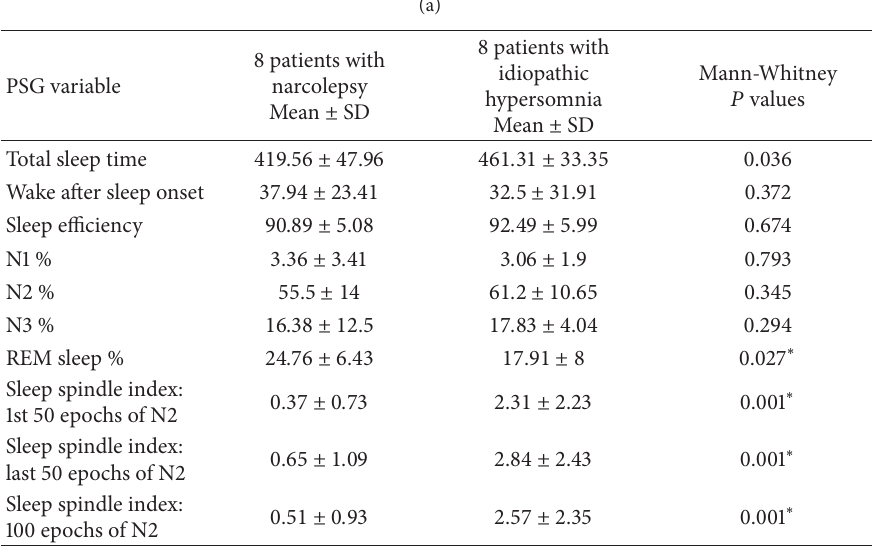
Table 2: (a) PSG data from narcoleptics and idiopathic hypersomniacs. (b) Intragroup comparison of sleep spindle index in 1st epochs of N2 sleep to last 50 epochs of N2